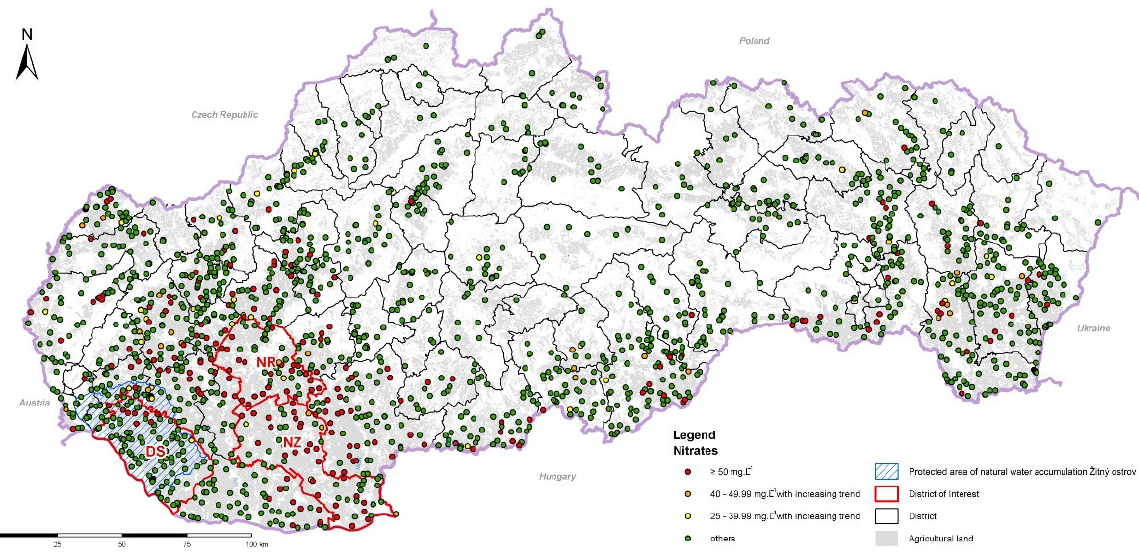
Figure 1. Spatial distribution of defined average nitrate concentrations in groundwater in 2016–2019 and allocation of selected districts. Table 1. Relative share of groundwater monitoring sites (%) with defined nitrate concentrations (mg L − 1 ) of the total within UAL of selected districts and pilot area.